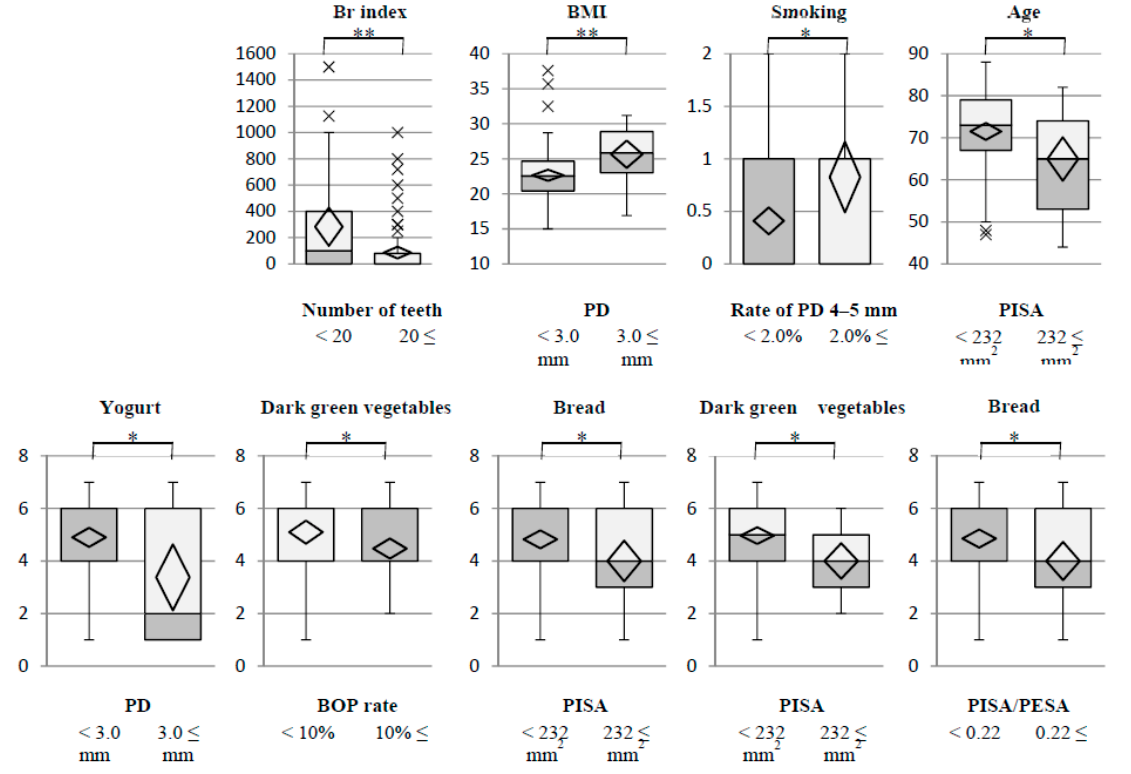
Figure 2. Box plot of environmental and nutritional factors. Differences in the population mean from clinical parameters are shown. The environmental and nutritional factors were limited based on statistically significant differences in the results of stratified descriptive statistics (Tables 3 and 4). Abbre-